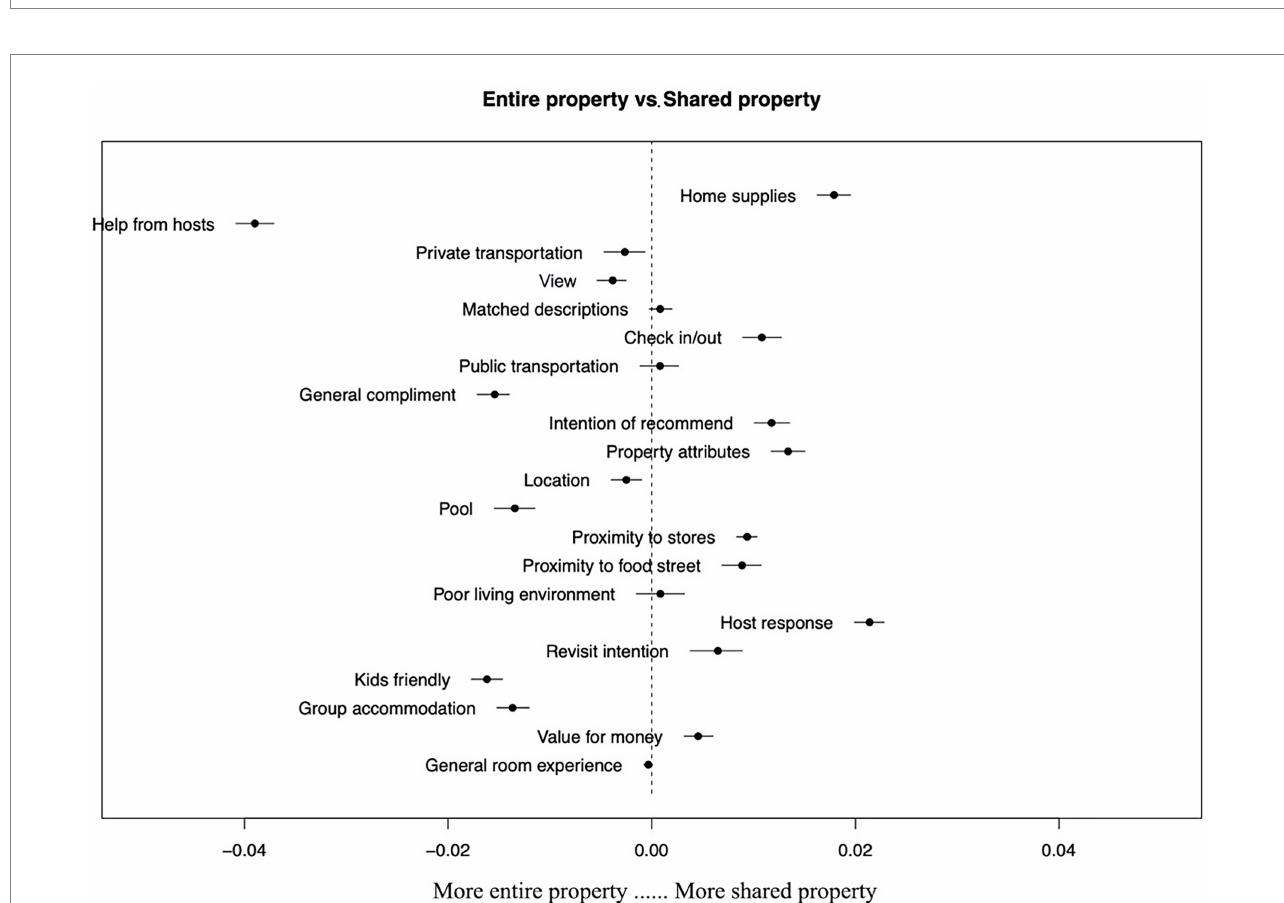
FIGURE 7 Changes in topic prevalence based on the accommodation type ( entire property vs. shared property